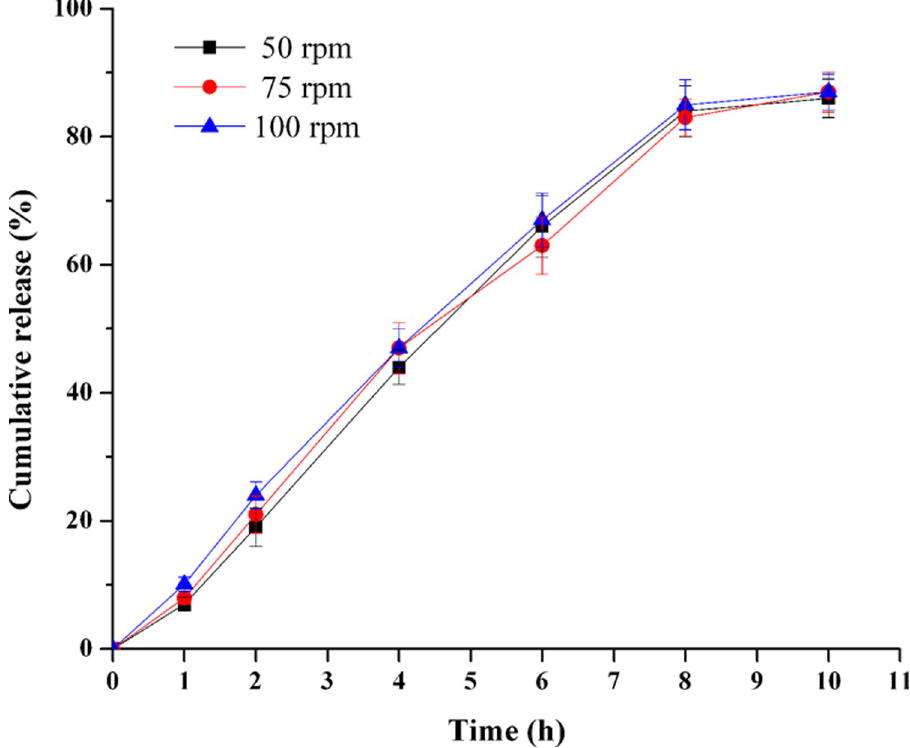
Fig 13. Effect of agitation rate on TPM release in optimal formulation (n =